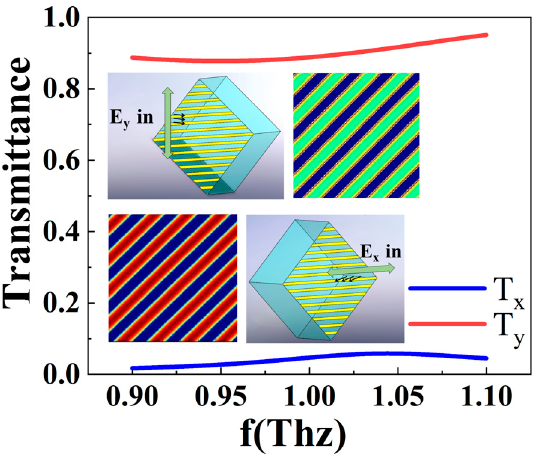
Figure 8. Effect of Cu line width on the ( a ) transmittance and ( b ) extinction ratio of the grating in the frequency range 0.9–1.1 Thz.